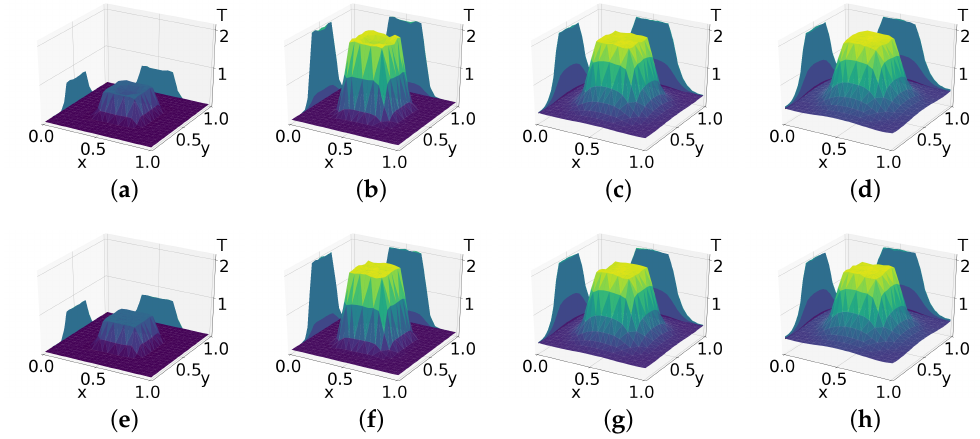
( t , x ) , ξ , t , x )] on the first prediction horizon ( 0, H ]